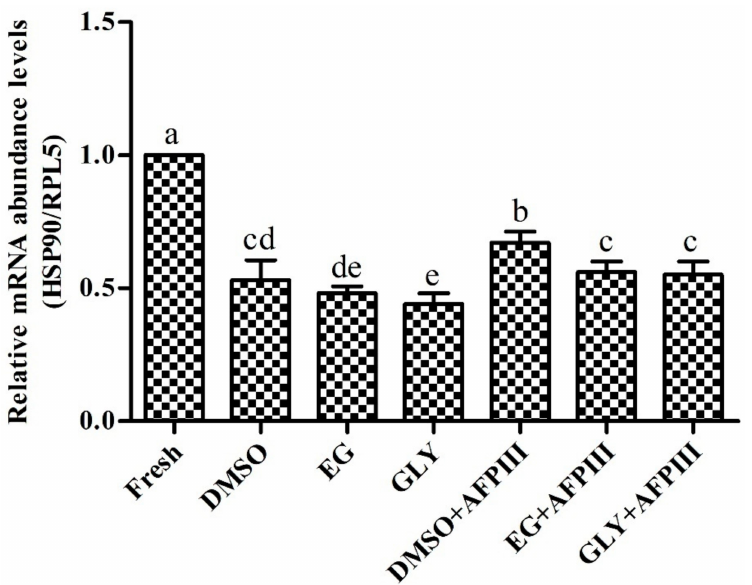
Figure 7. Abundance levels of heat shock protein 90 (HSP90) mRNA in different cryopreserved sperm samples ( n = 3) of H. discus hannai . Significantly different levels ( p < 0.05) are denoted by different letters.